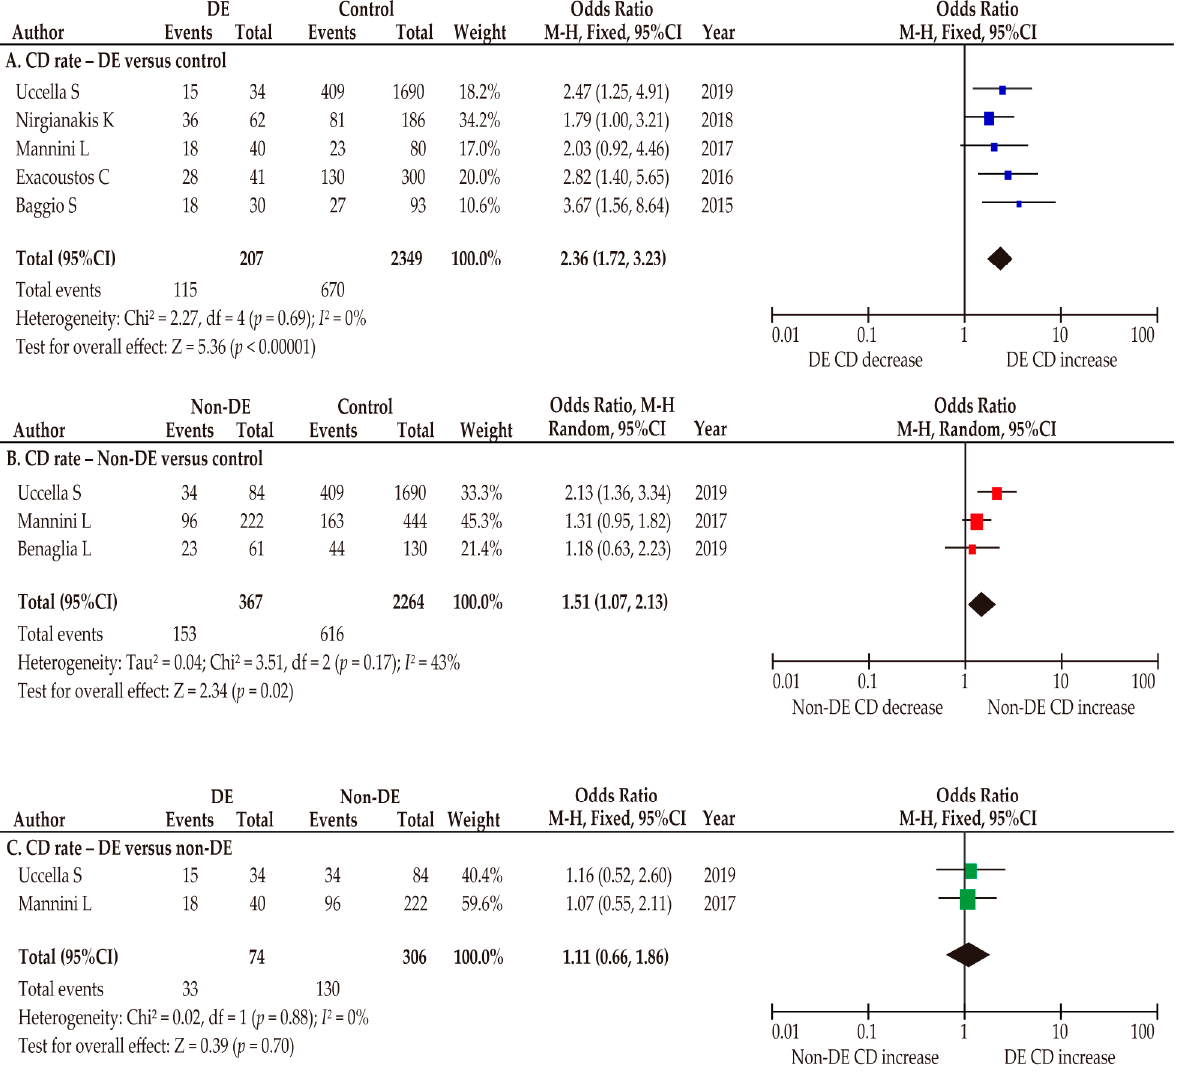
Figure 5. Meta-analysis of the effect of DE and non-DE on the CD rate. The pooled unadjusted odds ratio for CD ( A ) women with DE vs. women without endometriosis, ( B ) women with non-DE vs. women without endometriosis, and ( C ) women with DE vs. women with non-DE are shown. The forest plots were modified within the stratum according to year of publication and relative weight (%) of the study. Heterogeneity was low to moderate in three analyses (( A ), I 2 =0%; ( B ), I 2 = 43%; C , I 2 =0%). Some values listed might differ slightly from the original values because the calculation was performed using Revman v5.4.1. Abbreviations: CD, cesarean delivery; CI, confidence interval; DE, deep endometriosis.